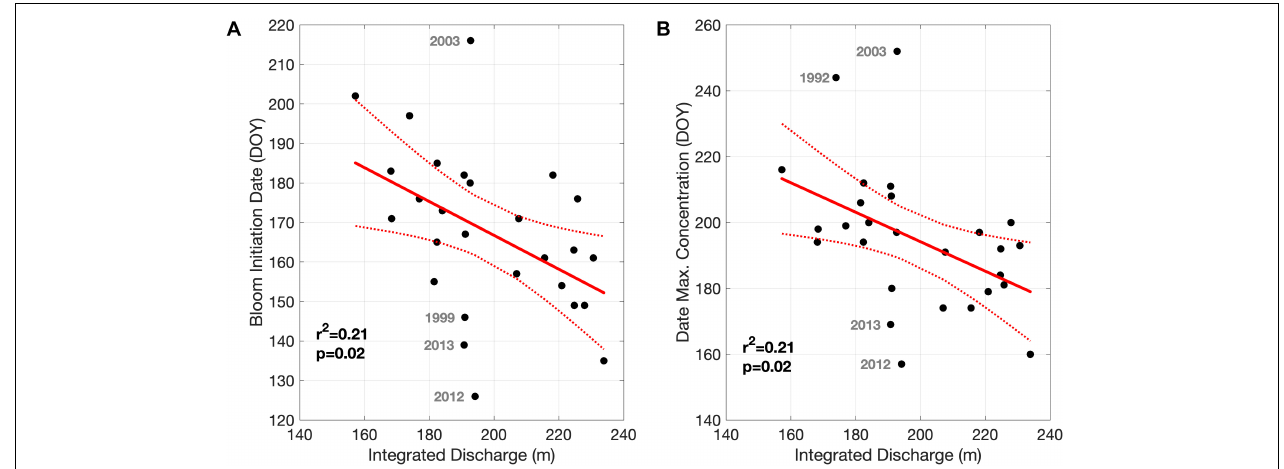
FIGURE 7 | Relationship between the integrated (March through May) freshwater discharge from the St. John River and the Bloom Initiation Date (A) and Date of Maximum Concentration (B) . Highlighted years are displayed in gray.